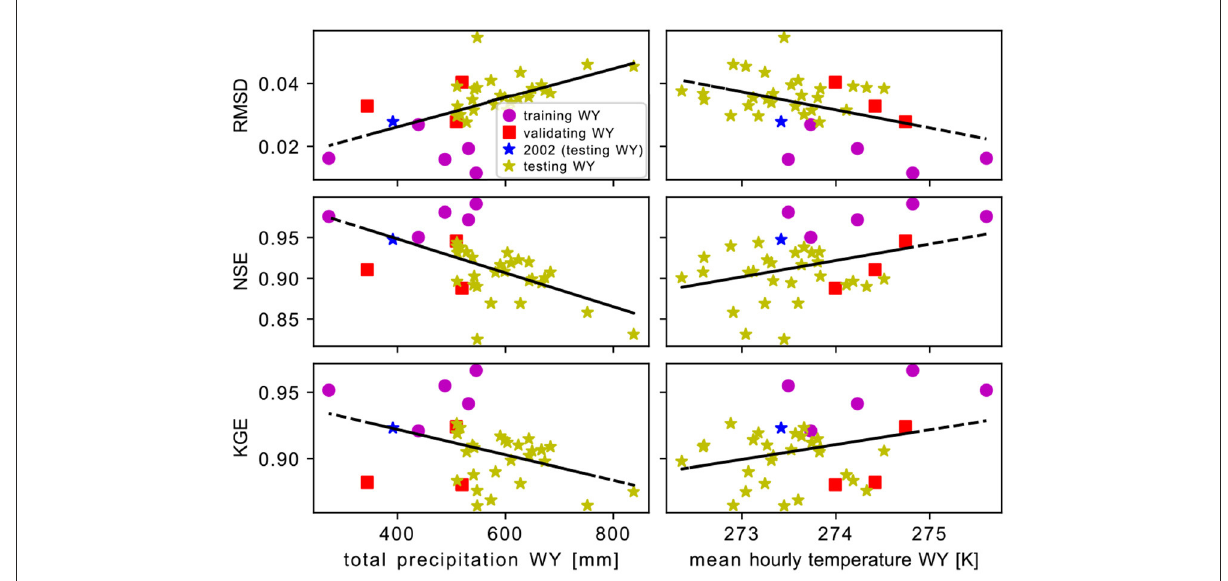
FIGURE9 The mean root mean square error (RMSD, first row of plots), Nash-Sutcliffe Efficiency (NSE, middle row of plots), and Klige-Gupta Efficiency (KGE, lower row of plots) as a function of the total precipitation (left column of plots) or the mean hourly temperature (right column of plots) computed for each water year. The color identifies water years used in training, validation, or testing. The water year 2002, used for all the results reported here is marked blue. Black lines represent the trends of a linear